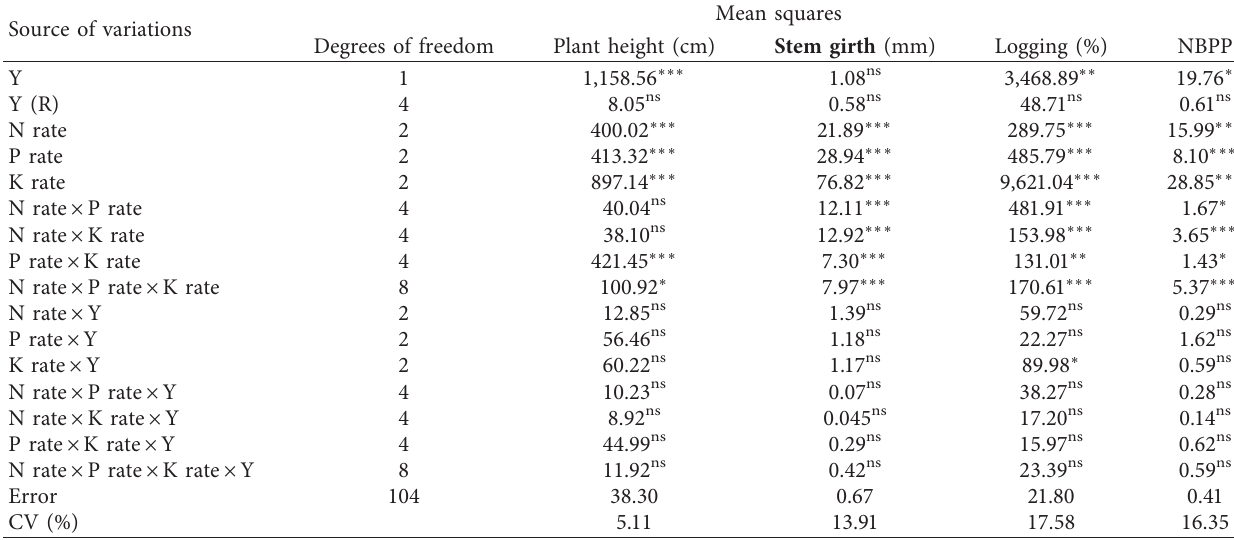
Table 3: Mean square values of the interaction effect of mineral N, P, and K and the effect of year on growth parameters of faba bean in Sodo Zuria District, southern Ethiopia, in 2019 and 2020 cropping seasons.